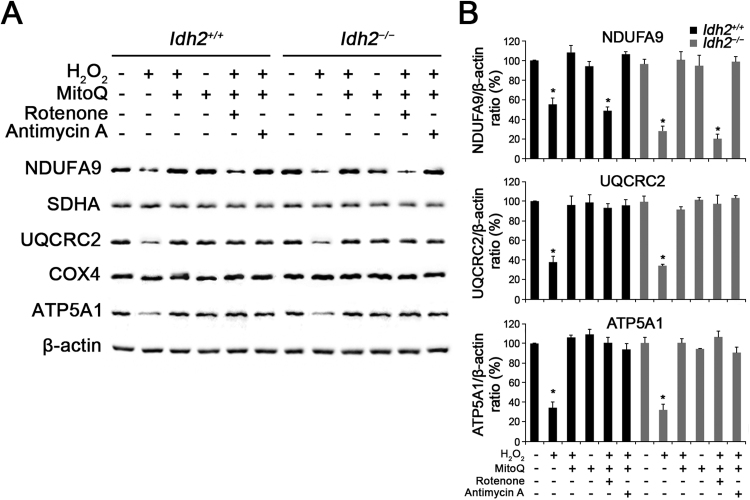
Decreased expression levels of mitochondrial respiratory chain complexes in H2O2-treated cochlear explants. (A) The organ of Corti explants of the Idh2+/+ and Idh2−/− mice were treated with H2O2 and/or MitoQ for 3 days. Altered expression levels of the oxidative phosphorylation (OXPHOS) subunits I, III and V were detected in the total protein lysates from H2O2-treated cochlea by Western blot analysis. β-actin served as a loading control. (B) Protein levels of OXPHOS complexes were calculated by densitometric analysis using ImageJ software (n = 3) Data are shown as the means ± SEM. *p < 0.05.